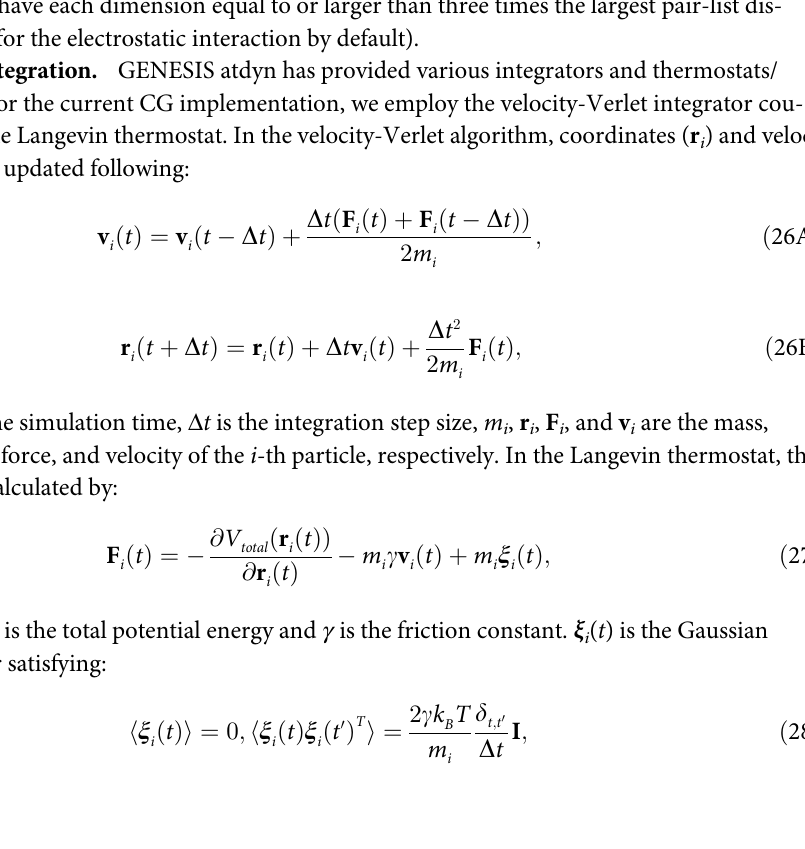
) contains the i ð C ð ele Þ ð C Þ ) are shown as the green neighbor ele i . k